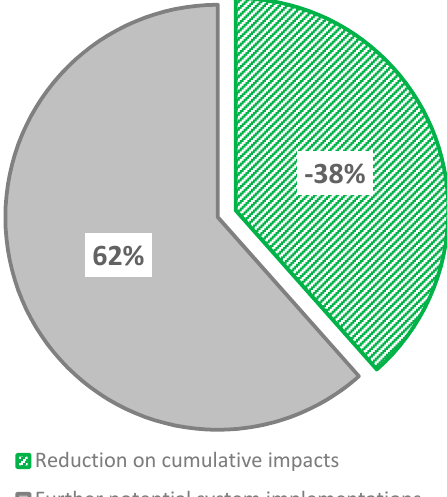
Figure 5. Contribution on cumulative score and potentialities of improvement.